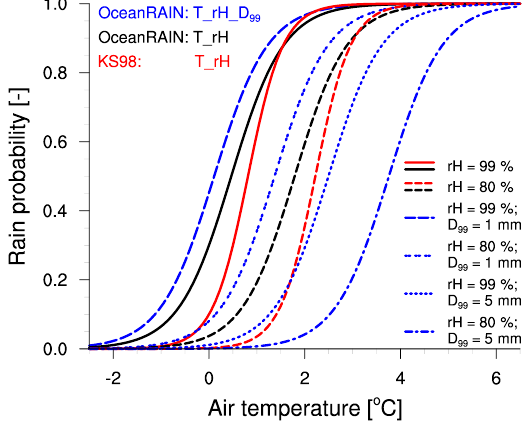
Figure 5. Rain probability using regression coefficients from Ta- ble 4 for OceanRAIN RS sub-data (2P1D) with the predictor vari- ables T _rH (black), T _rH_ D 99 (blue) both fitted against Ocean- RAIN, compared to KS98-recommended coefficients for T _rH (red). Dashed lines (black, red) indicate a PP distribution where rH is set to 80% while for solid lines it is set to 99%. For T _rH_ D 99 (blue lines), D 99 is set to either 1 or 5mm in addition to